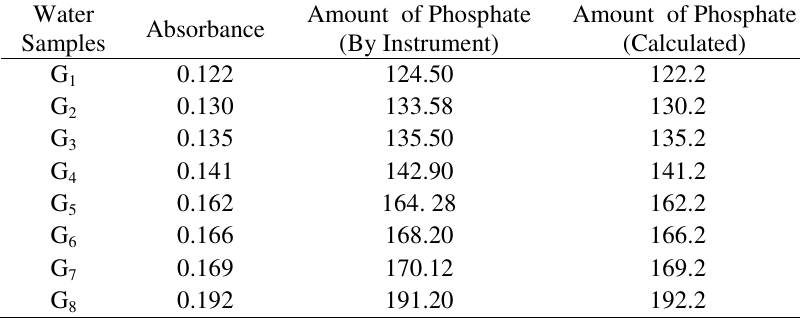
Table 3. Absorbance and concentration of phosphate (by Instrument and Calculation) of water samples of Godavari